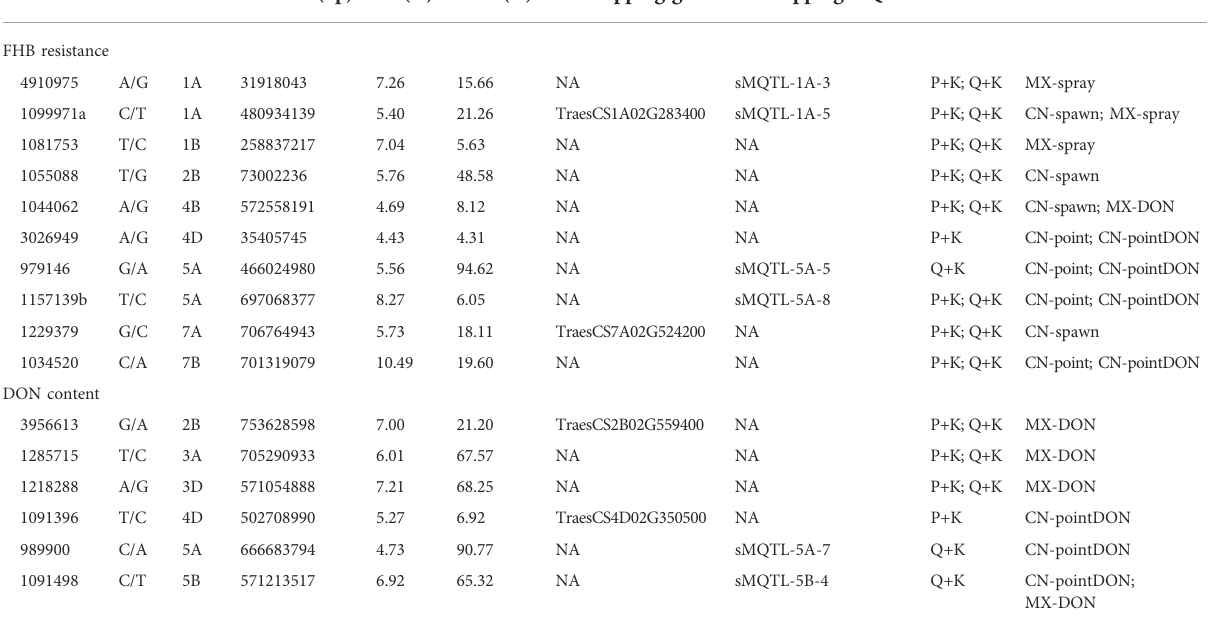
TABLE 3 Markers signi fi cantly (-log10( p ) ≥ 3.0) associated with FHB resistance and DON